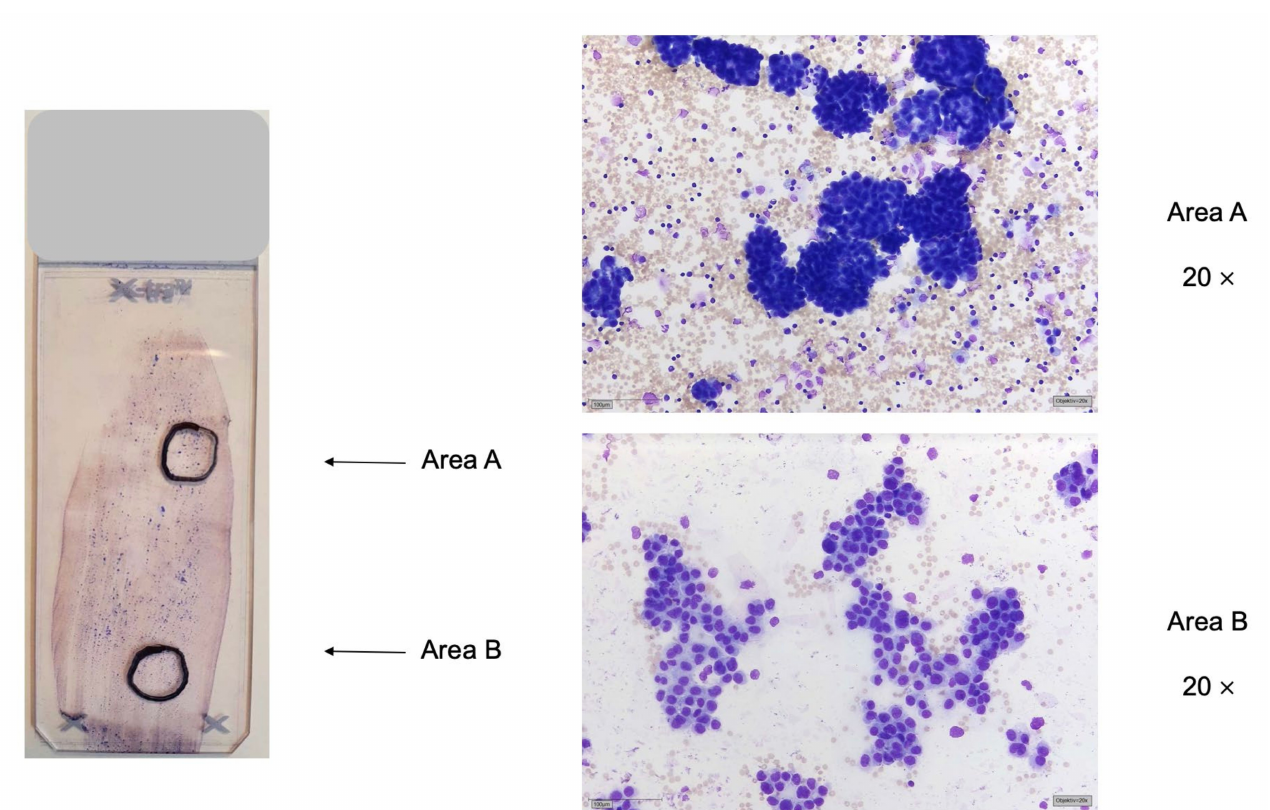
Figure 1. Marking of suitable areas for DNA extraction (area ( A )) or FISH analysis (area ( B ) by a cytopathologist. Left: sediment smear of pleural effusion of pulmonary adenocarcinoma, MGG stain. Two areas are marked up, area ( A ) for DNA extraction and parallel sequencing and area ( B ) for FISH analysis. Right: area ( A ): dense tumor cell clusters, suitable for DNA extraction and parallel sequencing; area ( B ): flat sheets of tumor cells, suitable for FISH